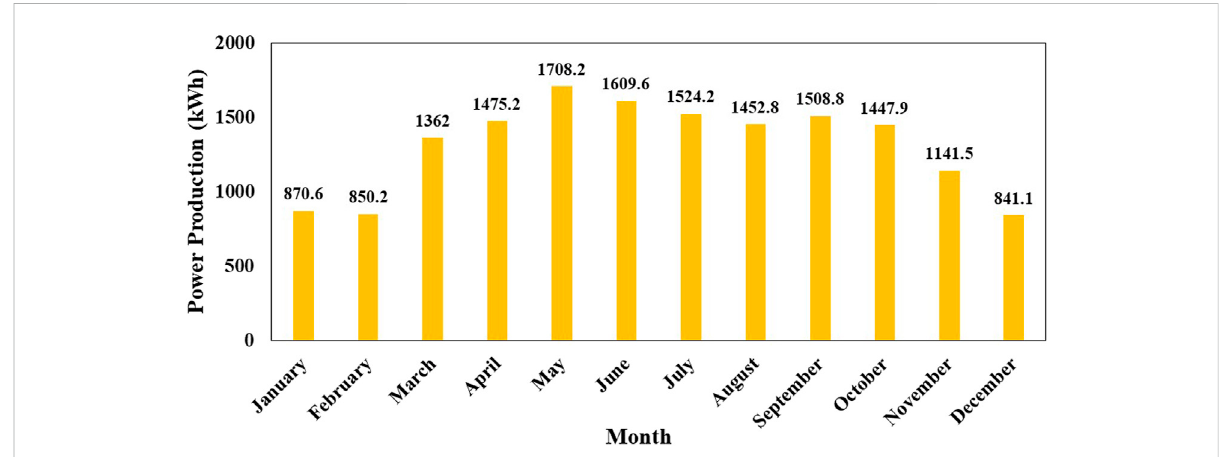
FIGURE 5 Photovoltaic system monthly power production.